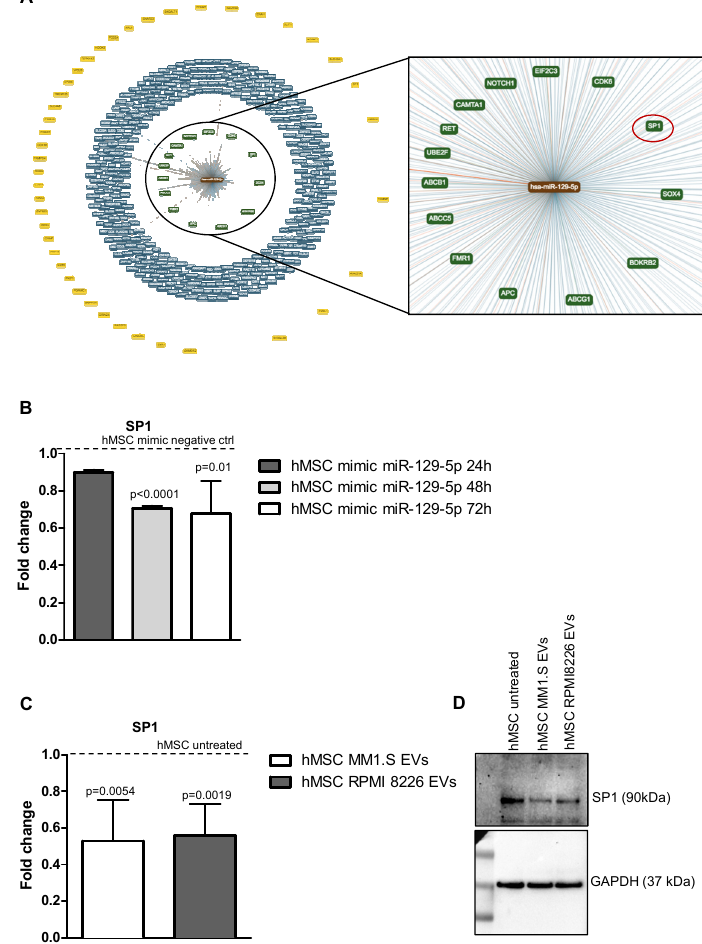
Figure 6. ( A ) The target and predicted genes of hsa-miR-129-5p were analyzed by the bioinformatics tool miRTargetLink Human. The central node represents miR-129-5p, surrounded by the validated target with strong (green) and weak (blue) evidence and the predicted targets in yellow. ( B ) The Real-time PCR analysis of Sp1 in hMSCs transfected for 24, 48 and 72h with miR-129-5p mimic. Data were